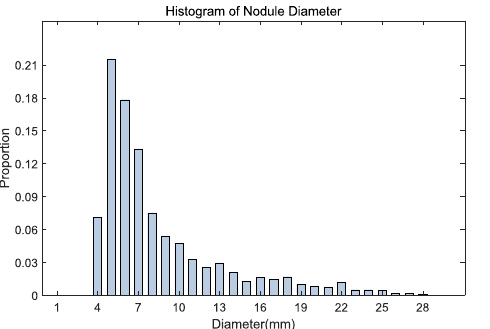
Figure 2. The histogram of nodule diameter (mm). The average diameter is 8.31 mm for all nodules, in the LUNA16